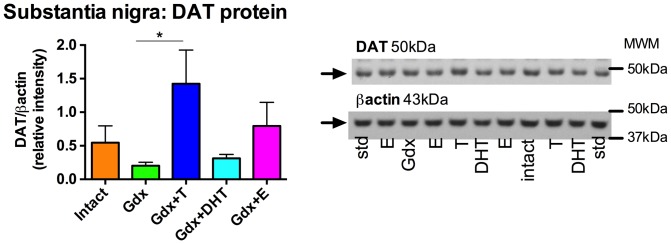
Effect of gonadectomy and sex steroid replacement on dopamine transporter protein in the substantia nigra of adolescent male rats.In the substantia nigra there was a trend for treatment group to change DAT protein (F = 2.52, df  =  (4,41), p = 0.056). Representative immunoblots of a subset of substantia nigra samples show DAT (50 kDa) and β-actin (43 kDa). A priori, planned comparisons, based on mRNA data, revealed that testosterone replacement increased DAT protein compared to the gonadectomised group. * p<0.05, n = 9–10/group. (MWM, molecular weight marker; std, internal standard).